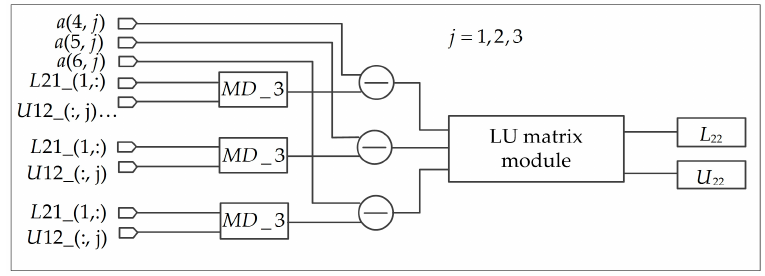
Figure 10. The architecture of L 22 and U 22 .